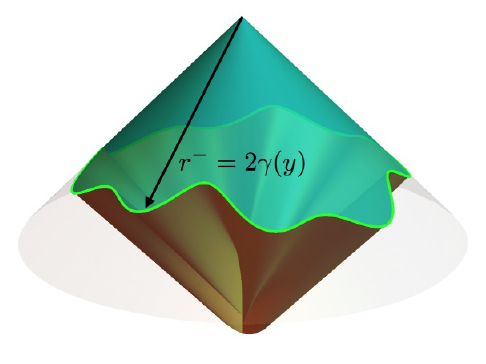
Figure 2 . A region with boundary on the light-cone. This setup applies for